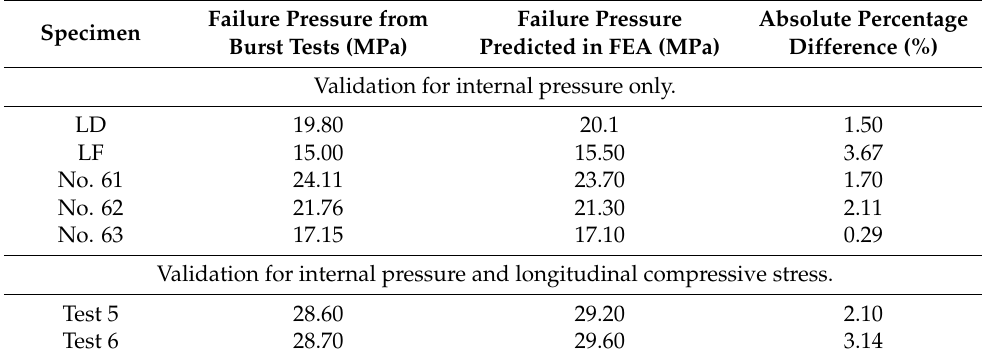
Table 7. Failure pressure from burst tests compared with failure pressure predicted in FEA.